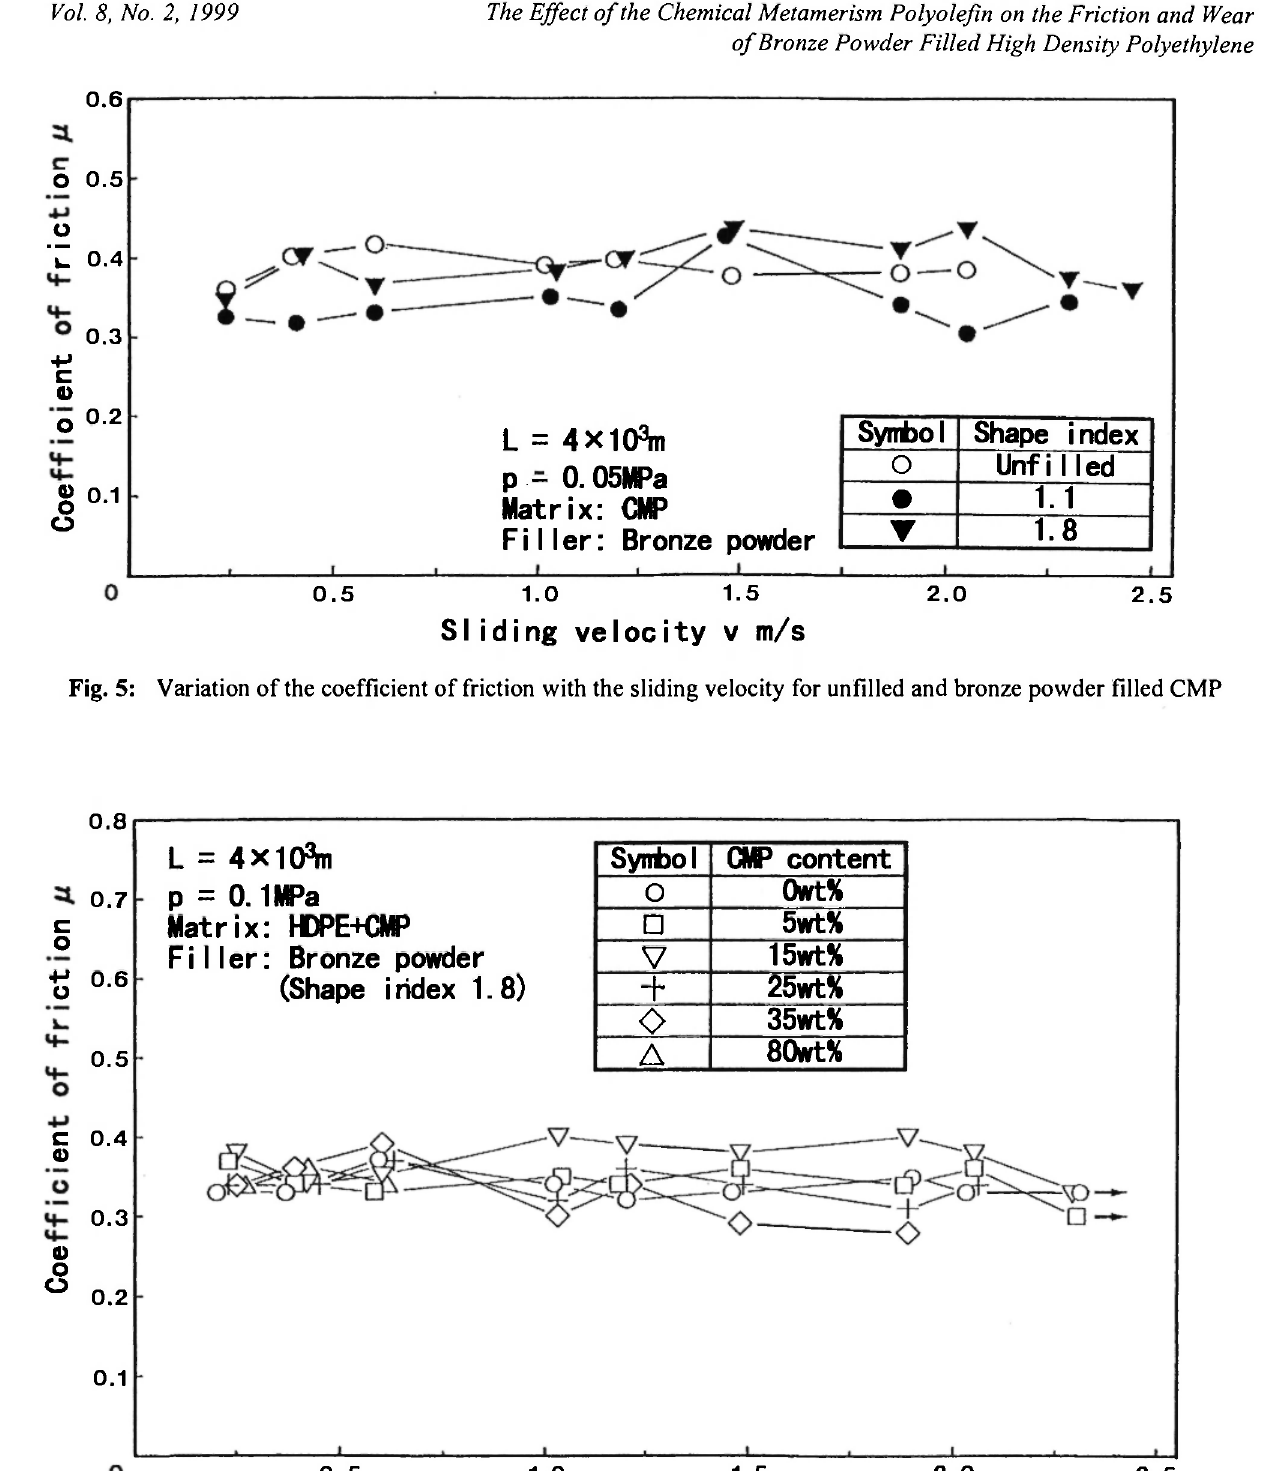
Fig. 6: Variation of the coefficient of friction with the sliding velocity for CMP-blended HDPE + Br (1 .8) and CMP